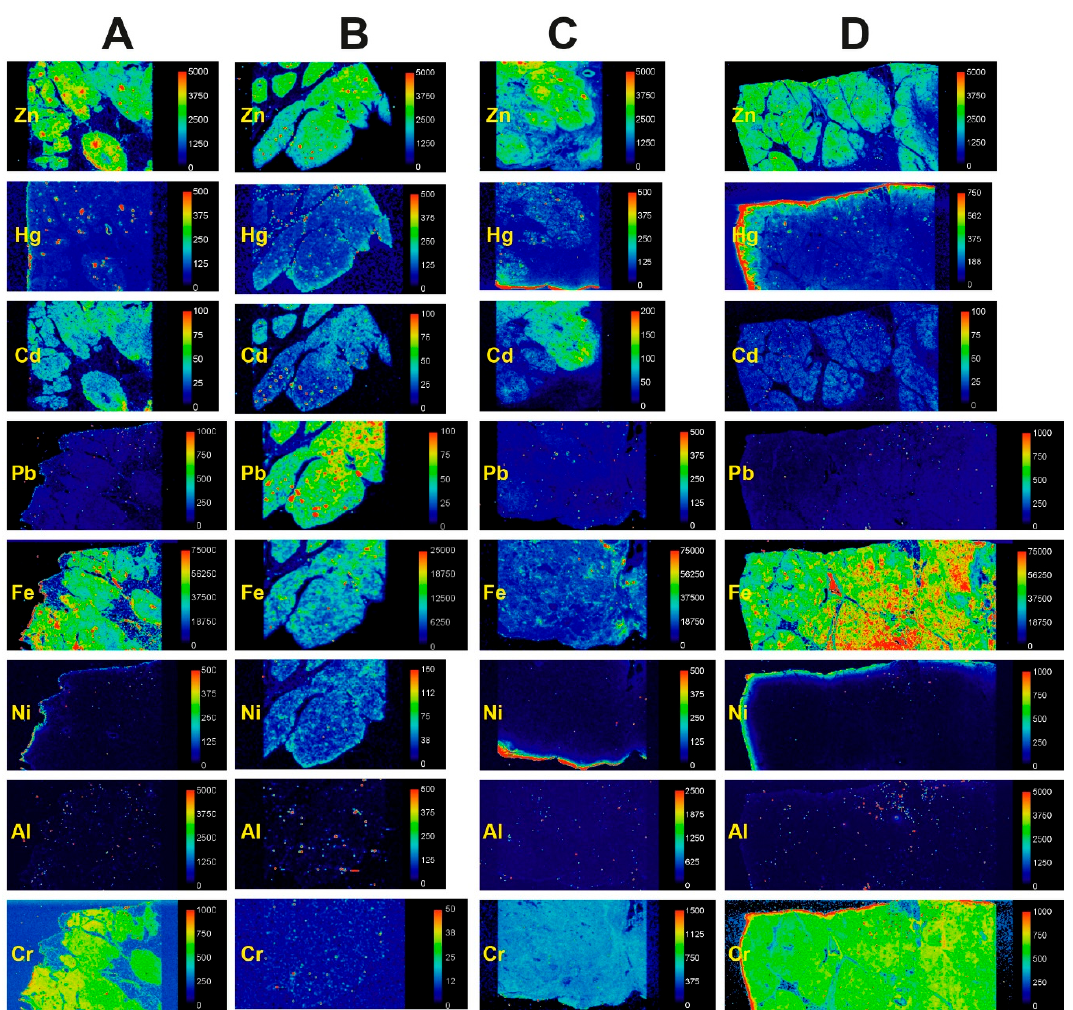
Figure 6. LA-ICP-MS of pancreatic samples containing AMG-positive islets. Zinc images show the overall cellularity of the tissue (yellow-green) as well as pancreatic islets (red) that contain focally higher zinc levels (some images may need to be enlarged to show these islets). ( A ) In this sample, mercury co-localises with zinc-positive islets (the top two images are shown enlarged in Figure 5). Di ff use chromium, and irregular cadmium and iron, are present. ( B ) Islet-located mercury and cadmium, focal and di ff use lead, and irregular iron, nickel, and aluminium, are present in this sample. ( C ) In this sample, islet-located mercury, di ff use chromium, and irregular cadmium and iron are present. ( D ) Islet-located mercury, di ff use chromium, and irregular iron are present in this sample. Artefactual edge e ff ects are seen in some mercury, nickel, and chromium images (e.g., in ( D )). Scale = counts per second (proportional to